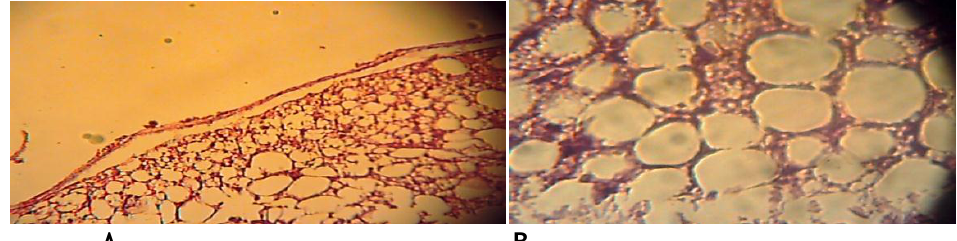
Figure (4) Adrenal gland tissue of the mouse after treated with purified CT (A- magnification 50X, B- magnification 100X